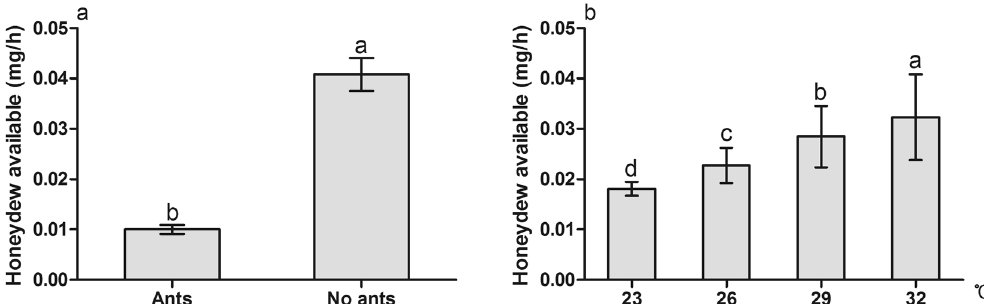
Figure 5. Effect of ant tending and temperature warming on the available honeydew mass excreted by mealybug. ( a ) Ant tending; ( b ) Temperature. Results are expressed as the means ± SE. Bars sharing the same letters indicate no significant differences between the treatments ( P >